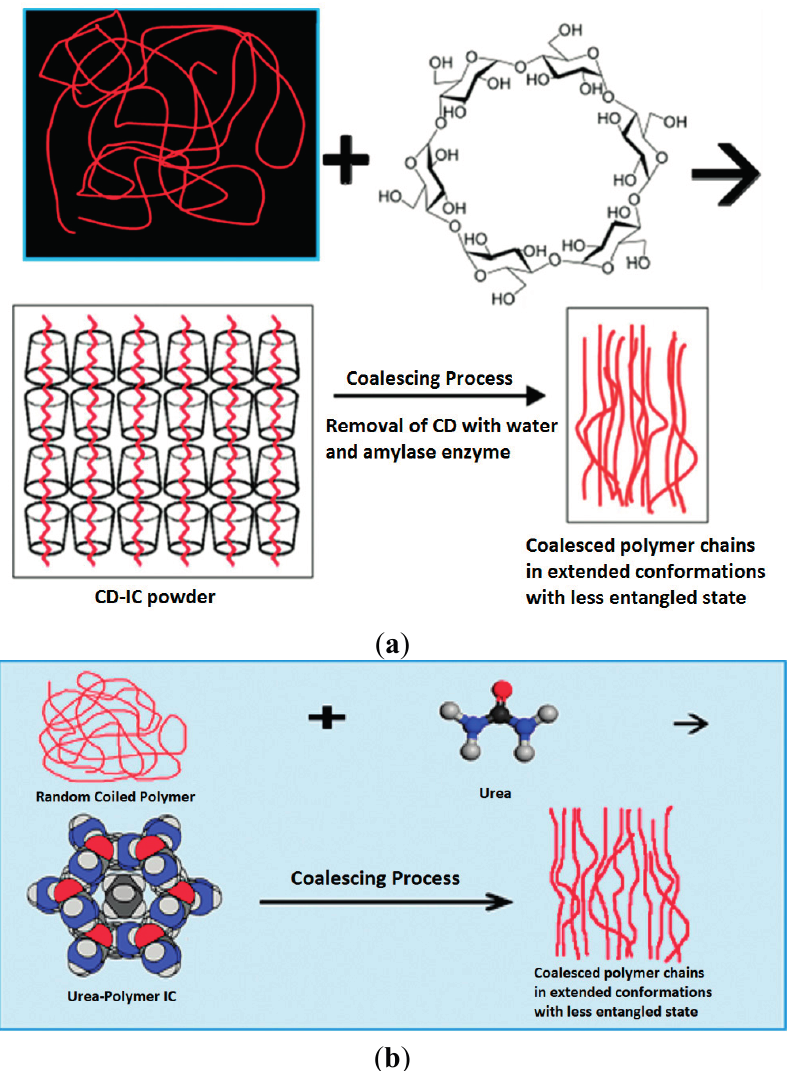
Figure 6. Formation and coalescence from CD ( a ) and U ( b ) polymer ICs